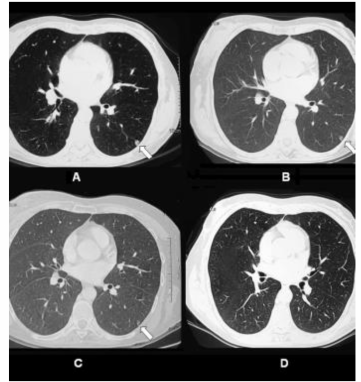
Figure 1. CT scans of pulmonary metastatic nodule in the left lung of 47-year-old female patient with stage IV breast cancer treated by laser ablation and IP-001 application. ( A ) CT scans of the patient taken before the first treatment. Small metastatic nodule was located in the left lung of the patient (indicated in arrow). ( B ) CT scans taken 1 week after the first treatment. ( C ) CT scans taken 2.5 months after the first treatment. ( D ) CT scans taken 12 months after the first treatment. This figure is reproduced from [35], with permission by the Royal Society of Chemistry and Owner